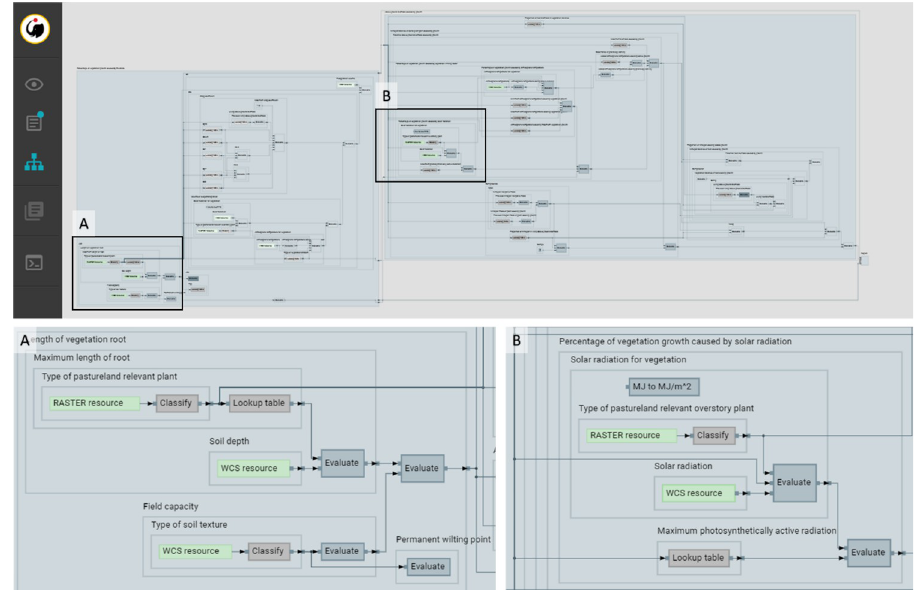
Fig 14. Dataflow of “Above ground biomass caused by growth” model created on the fly as the model runs. (A) and (B) show dataflow in detail and its boxes.